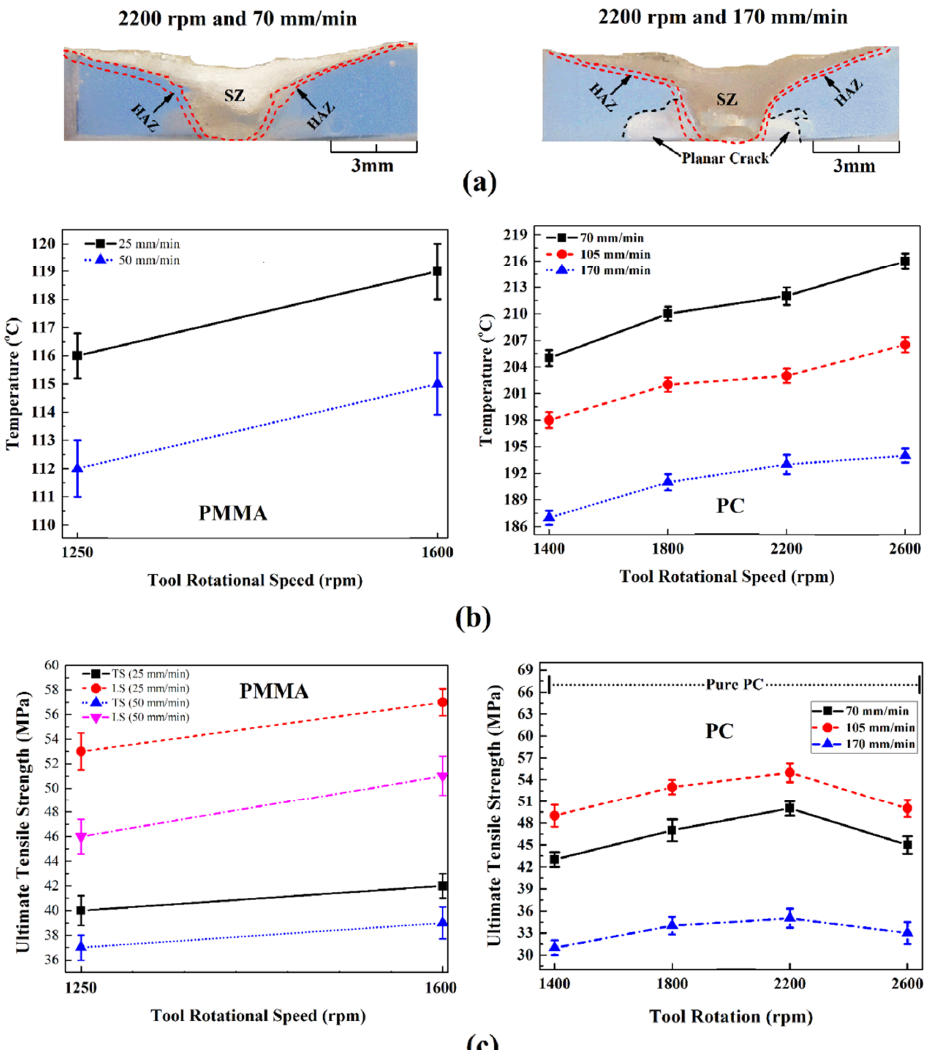
Figure 14. ( a ) effects of welding speed (V) on internal flow of polycarbonate (PC) joint after LFSW [42], ( b ) effects of welding speed on maximum recorded heat during LFSW of PC and PMMA [42,51], ( c ) e ff ects of welding speed on tensile strength of PC and PMMA after LFSW